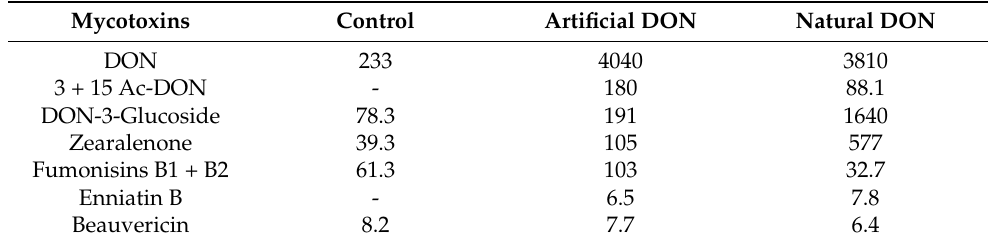
Table 1. Mycotoxins’ levels ( µ g/kg) in the experimental treatments in the starter period (D0–14). Mycotoxins Control